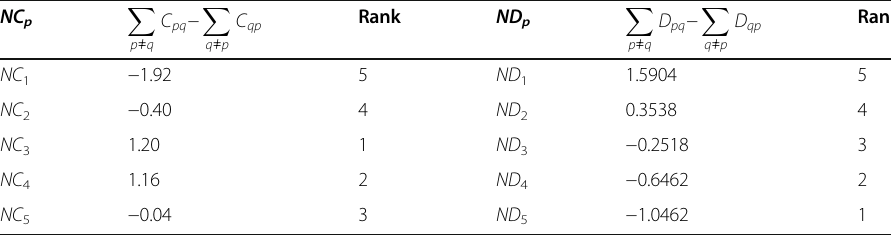
Table 8 Net concordance and discordance indices